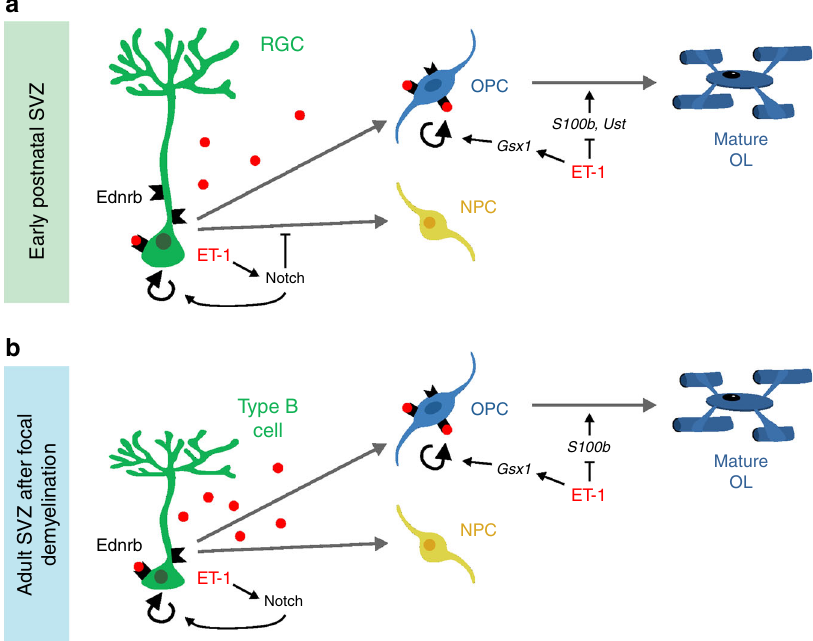
Fig. 9 Model of ET-1 signaling in the postnatal SVZ. a In the developing postnatal SVZ, RGCs secrete ET-1, which binds to Ednrb receptors on RGCs in an autocrine manner to activate Notch signaling. This leads to upregulation of stem cell genes and downregulation of proneural factors, resulting in RGC maintenance and proliferation. ET-1 also binds to Ednrb receptors on OPCs within the SVZ to upregulate the transcription factor Gsx1 and downregulate OL maturation factors S100b and Ust , thereby promoting OPC proliferation and blocking maturation. b Following demyelination of the SCWM, Type B cells in the adult mouse SVZ upregulate ET-1. This induces upregulation of Notch signaling components Jag1 and Hes5 in Type B cells, leading to increased proliferation. ET-1 also induces upregulation of Gsx1 and downregulation of S100b in SVZ OPCs, increasing their proliferation as